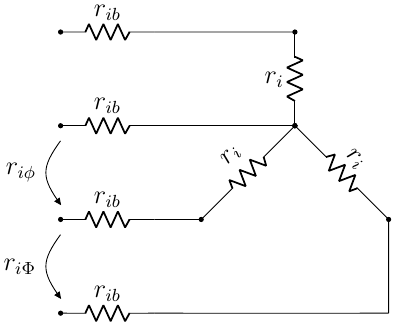
Figure 3. Proposed DC model for Y winding.